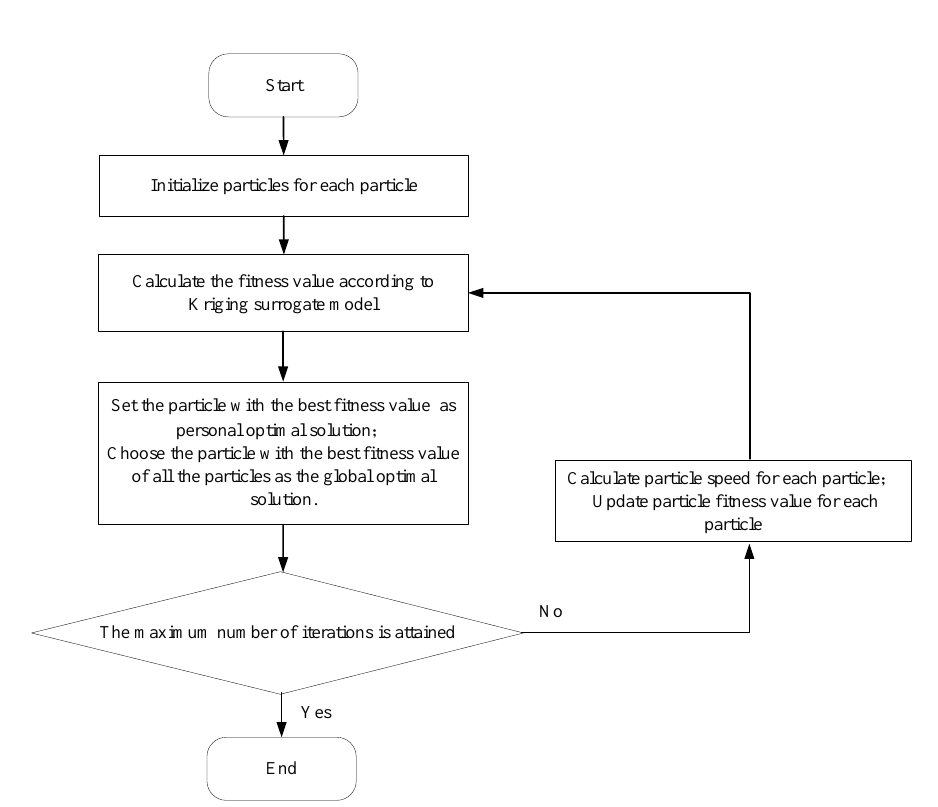
Figure 11. The general procedure of particle swarm optimization (PSO).